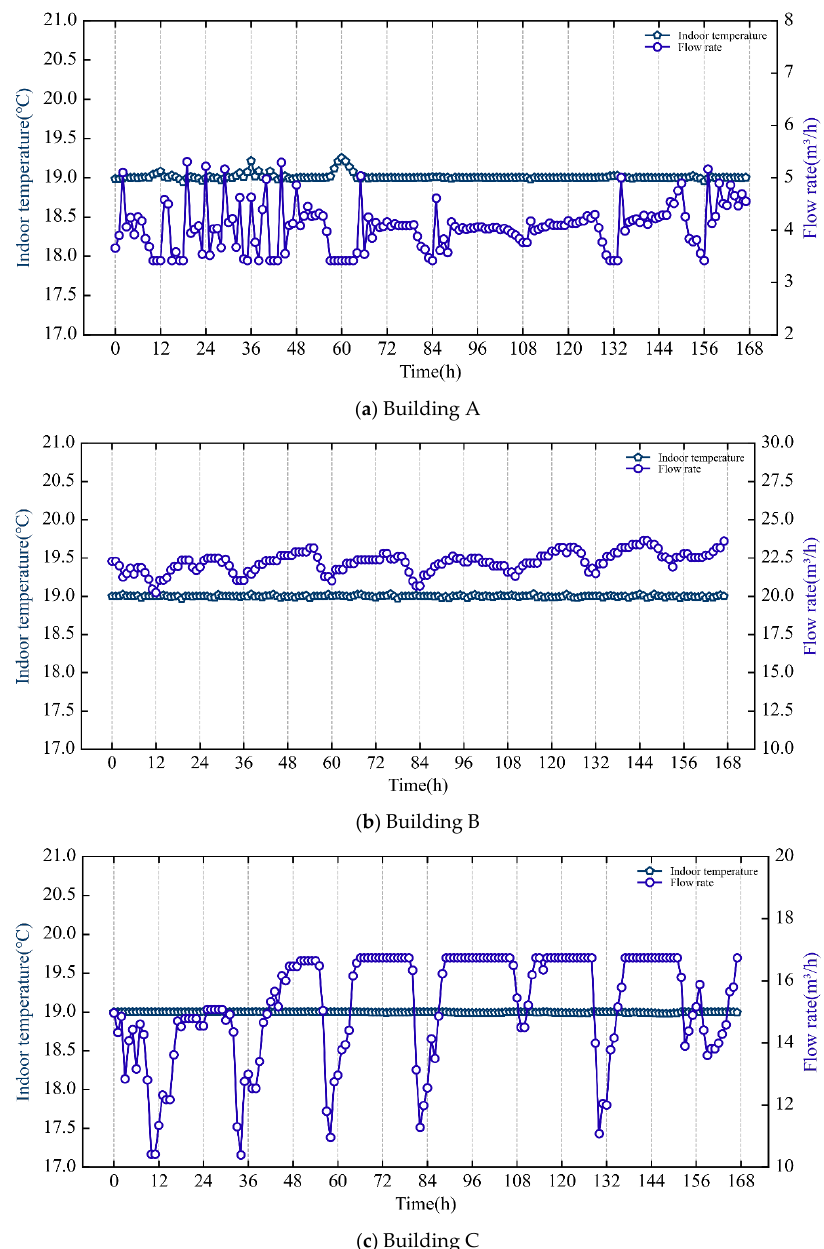
Figure 13. The simulated flow rate and indoor temperature changes of three buildings for one week.